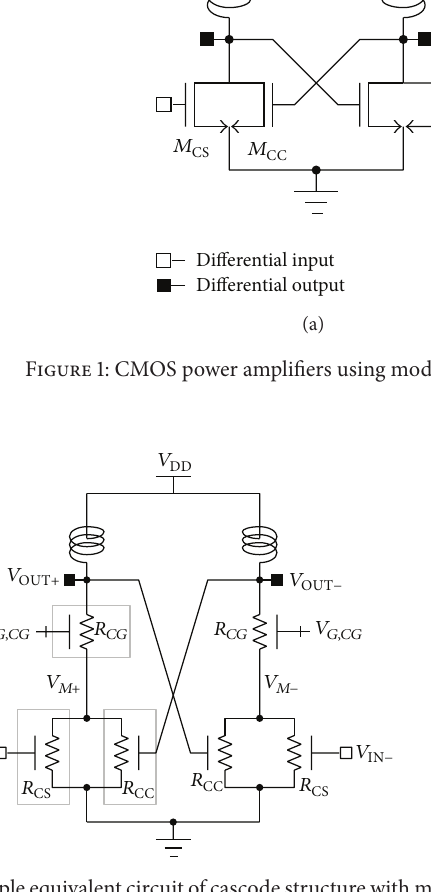
Figure 2: Simple equivalent circuit of cascode structure with mode- locking method.